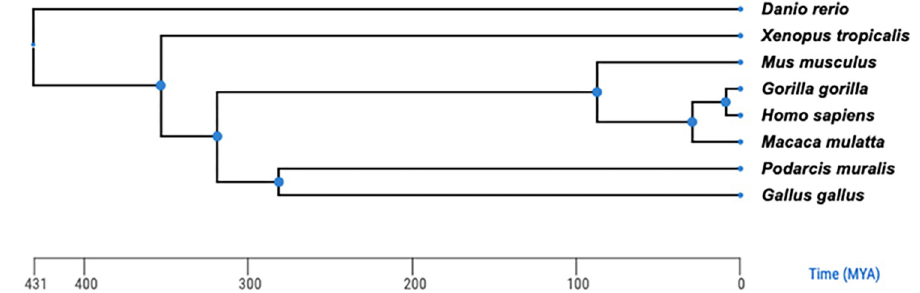
Fig 4. Evolutionary relationships between human and outgroup species. A dendrogram illustrating the evolutionary relationships of functional OR genes between the indicated